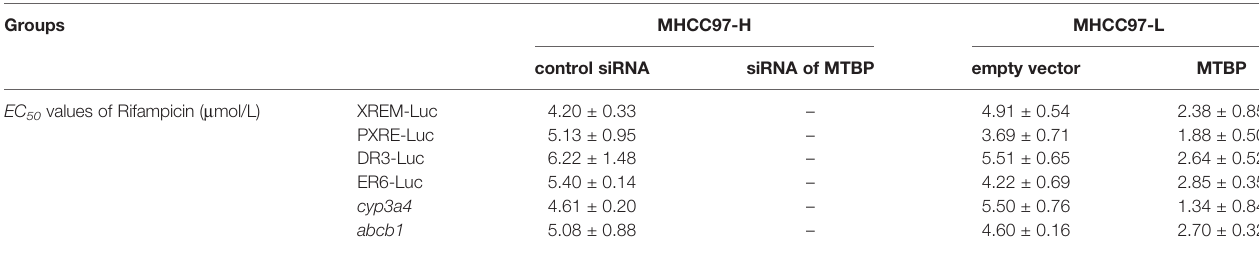
TABLE 1 | The effect of MTBP on PXR ’ s transcription factor activation. Groups